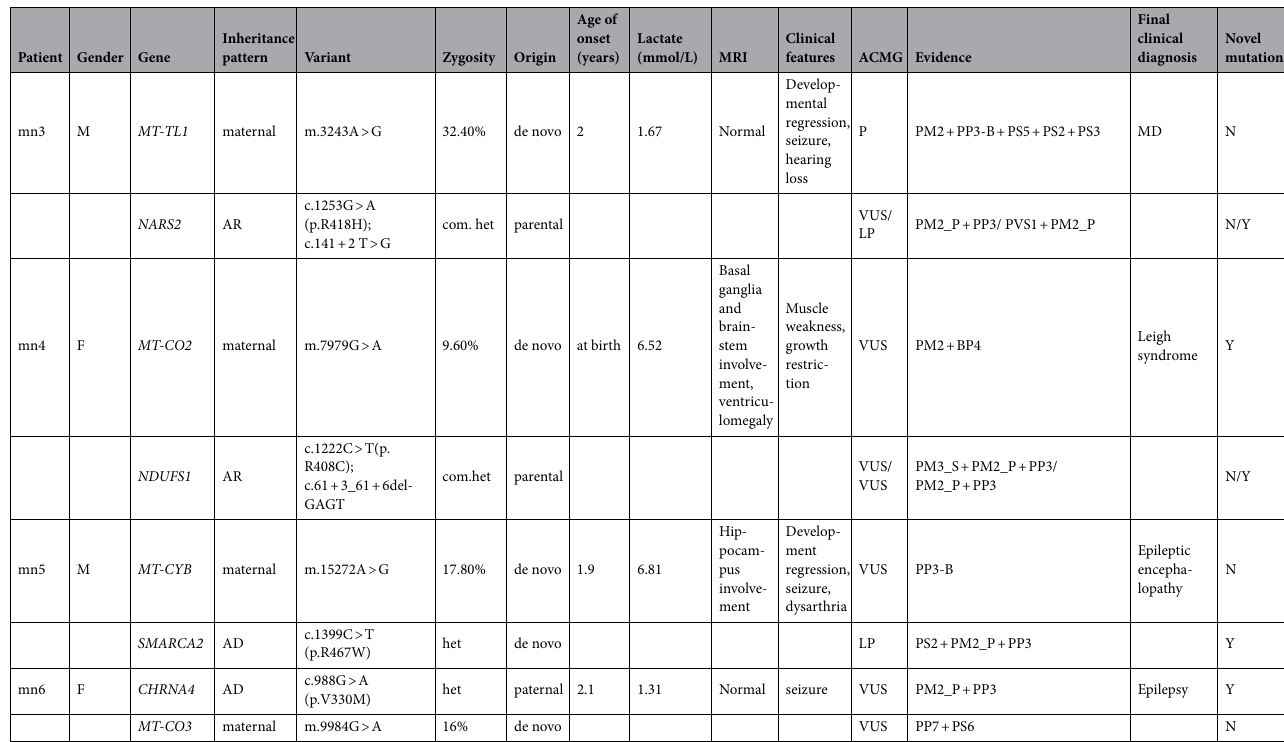
Table 1. Summary of clinical features of patients with mtDNA or/and nDNA variants. F, female; M, male; Na, not available; hom. homozygote; het, heterozygote; com. het. compound heterozygote; hem, hemizygote; DD, development delay; ID, intellectual disorder; NEMMLAS, neurodevelopmental disorder, mitochondrial, with abnormal movements and lactic acidosis, with or without seizures; GDD, global developmental delay; MELAS, mitochondrial myopathy, encephalopathy, lactic acidosis, and stroke-like episodes; LHON, Leber’s hereditary optic neuropathy; MD, mitochondrial disease; EIEE, early onset epileptic encephalopathy; KSS, Kearns-Sayre syndrome; ACMG, American College of Medical Genetics and Genomics; P, pathogenic; LP, likely pathogenic; VUS, variant of uncertain significance. Family history: n111, father had seizure; 2n5, mother, mother’s sister, father, two father’s sisters, and grandmother have ptosis; m8, mother had